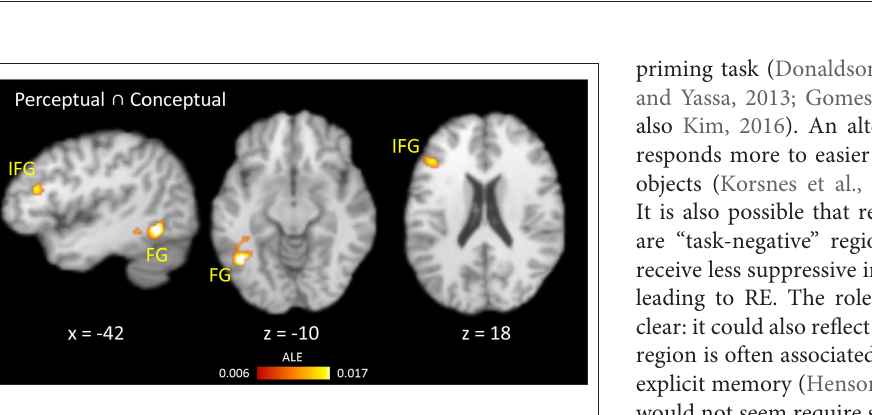
FIGURE 4 | Results of conjunction analysis. Brain regions showing RS for both conceptual and perceptual